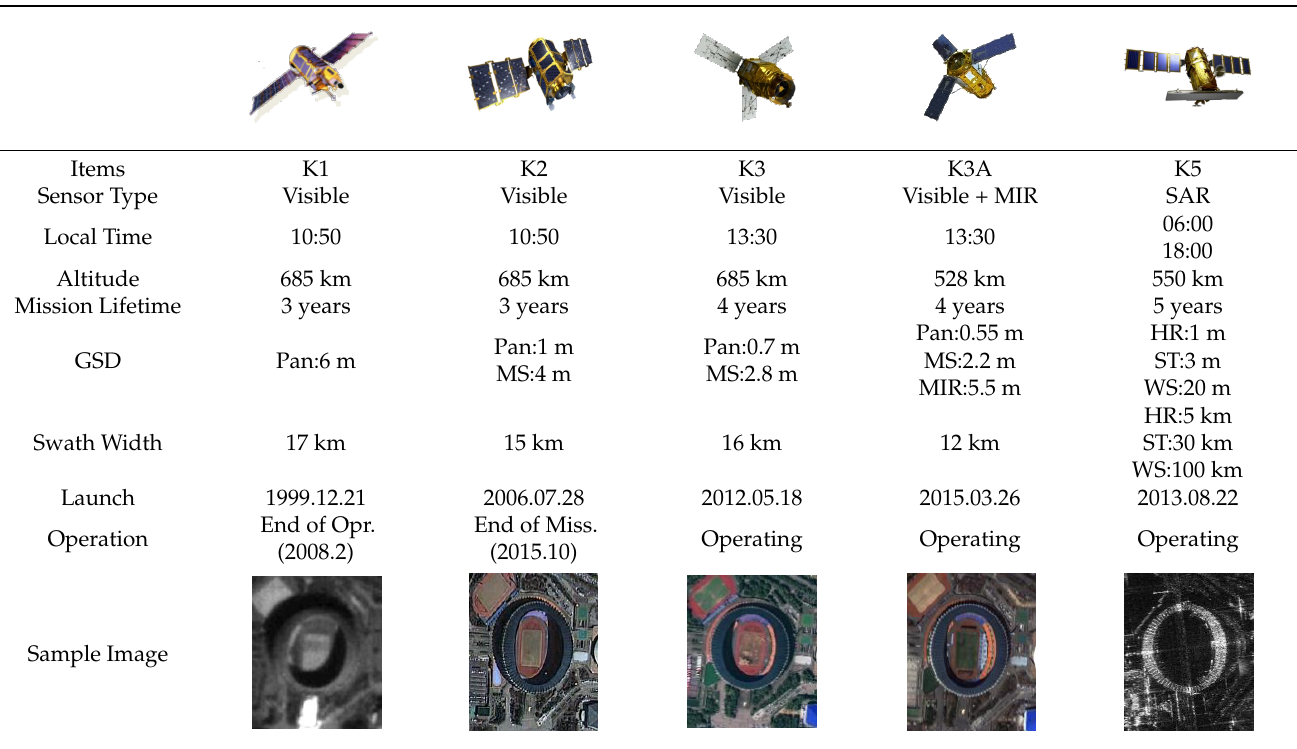
Table 1. KOMPSAT Series Specifications and Sample Images.